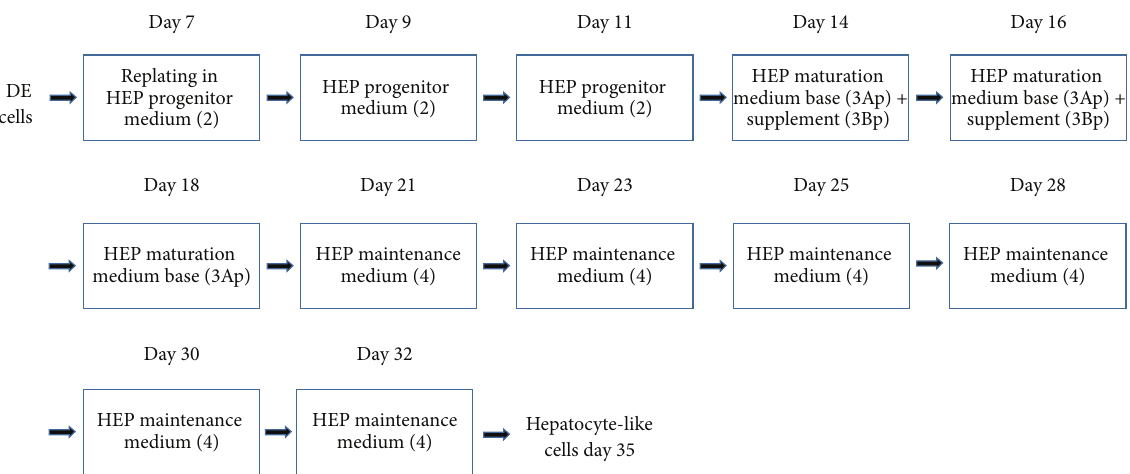
Figure 1: Schematic overview of the protocol used for the hepatic differentiation. The DE cells were harvested at day 7 and replated in HEP progenitor medium (2) on plates coated with the specific hepatocyte coating (1), which is included in the prototype of Cellartis Hep differentiation kit (Takara Clontech). Medium change with HEP progenitor medium (2) was performed at days 9 and 11. At days 14 and 16 the cells received HEP maturation medium base (3Ap) and supplement (3Bp). At day 18 the cells received HEP maturation medium base (3Ap).